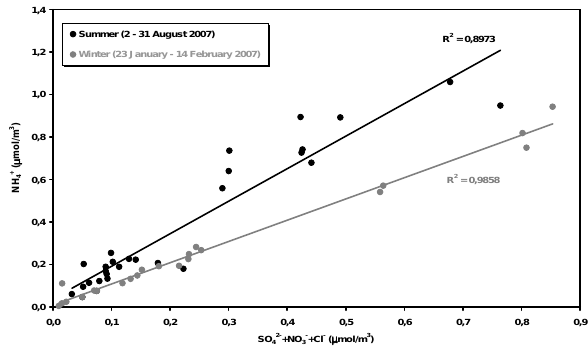
Fig. 2. Relationship between molar concentrations of fine particu- ) and the sum of the molar concentrations of late ammonium (NH + 4 ) , nitrate (NO − ) and chloride (Cl − ) fine particulate sulphate (SO 2 − 4 3 on the Teflon filters during the winter and summer measurements, carried out on a 24-h basis, at